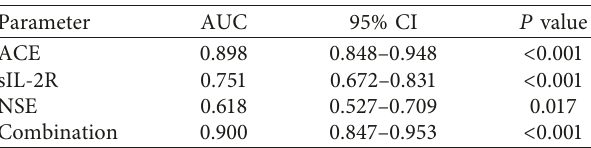
Table 3: ROC analysis for ACE, sIL-2R, NSE, and the combination for